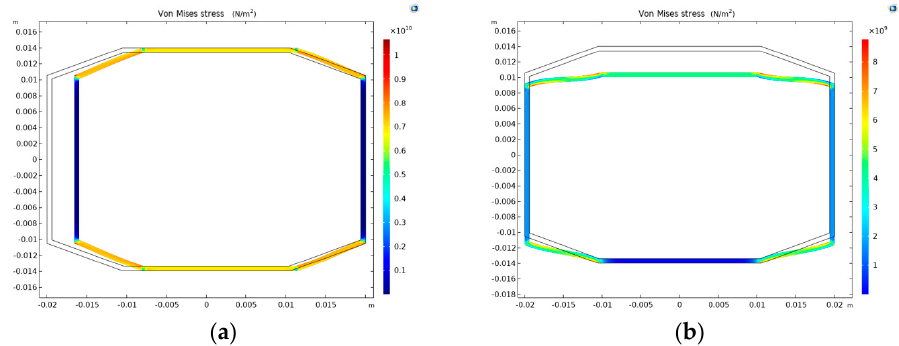
Figure 6. Structural stress distribution of octagonal frame structure under characteristic compressive stress conditions: ( a ) x direction stress; ( b ) y direction stress.